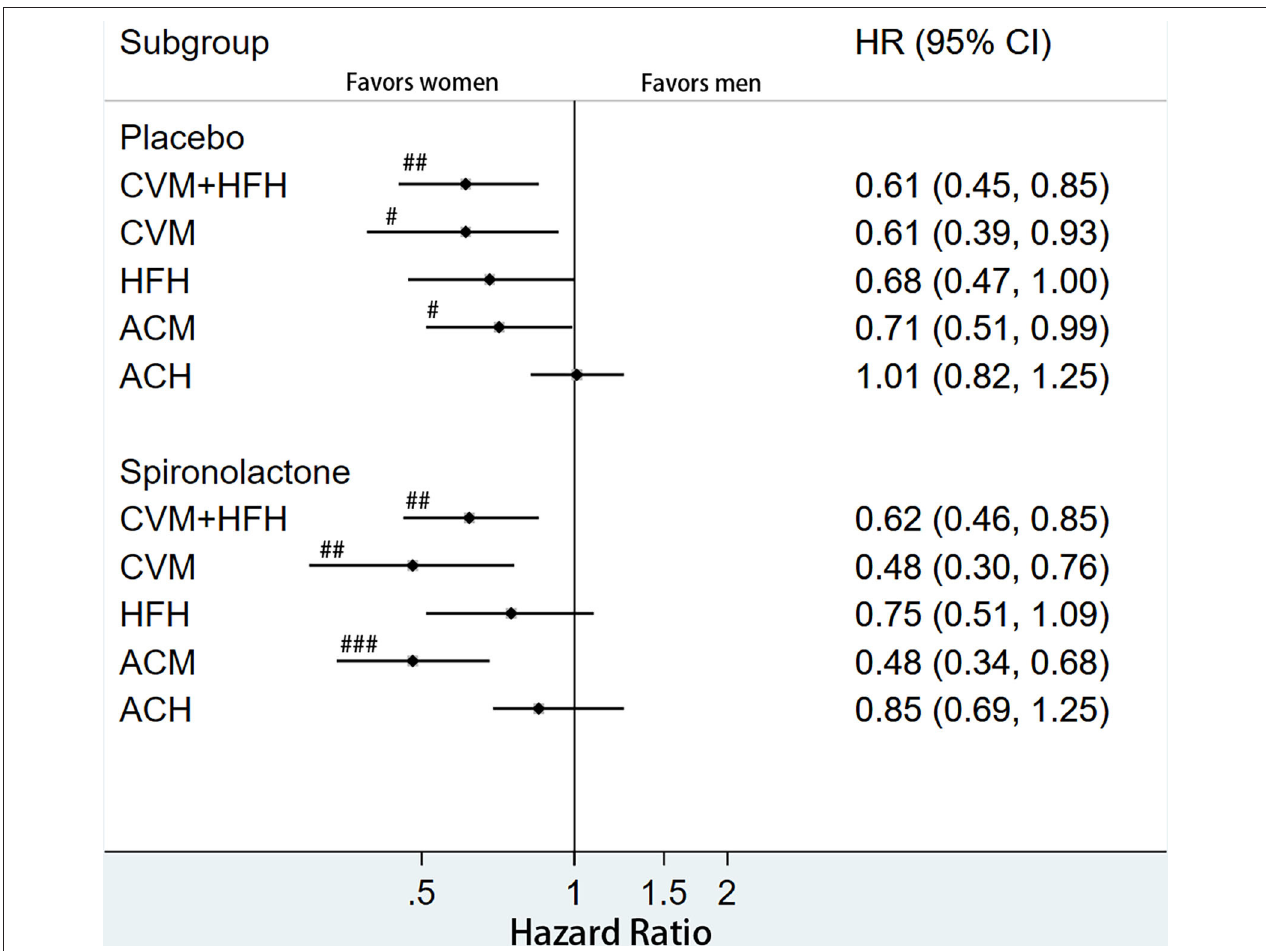
FIGURE 3 | Multivariate hazard ratios for primary and secondary outcomes according to treatment arm and stratified by sex. # p < 0.05, ## p < < 0.01, ### p < 0.001. ACM, all-cause mortality; CVH, cardiovascular hospitalization; CVM, cardiovascular mortality; HFH, heart failure hospitalization; ACH, all-cause